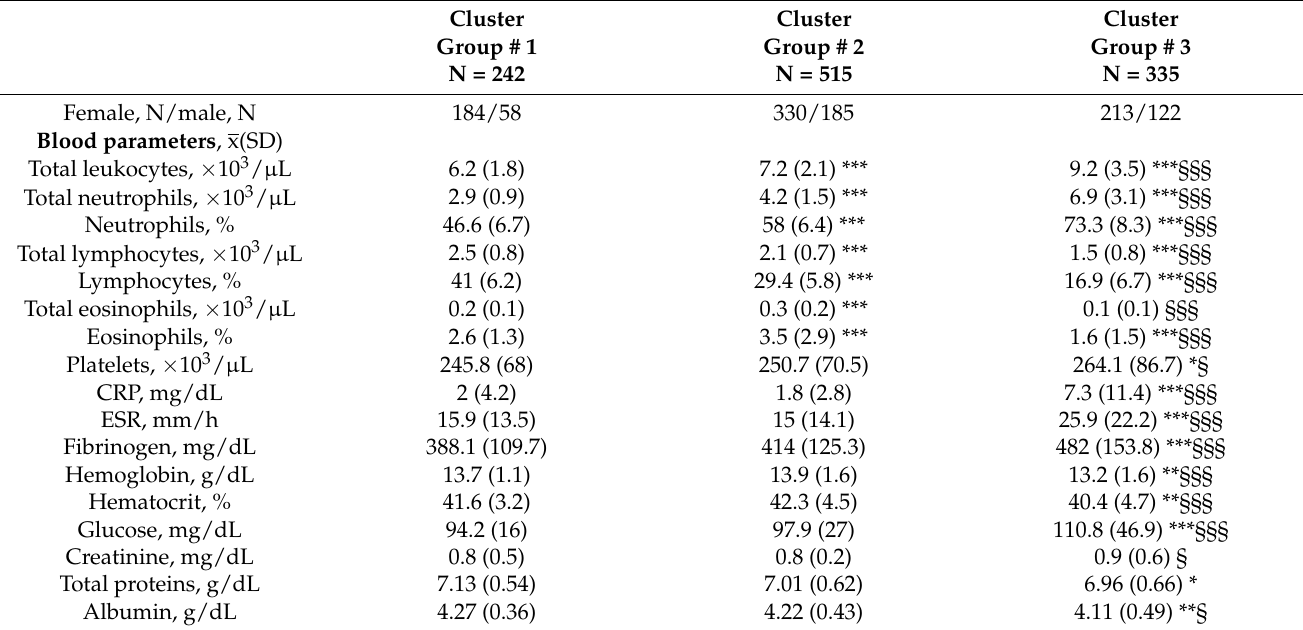
Table 4. Systemic inflammatory and nutritional parameters in the study patients according to clusters